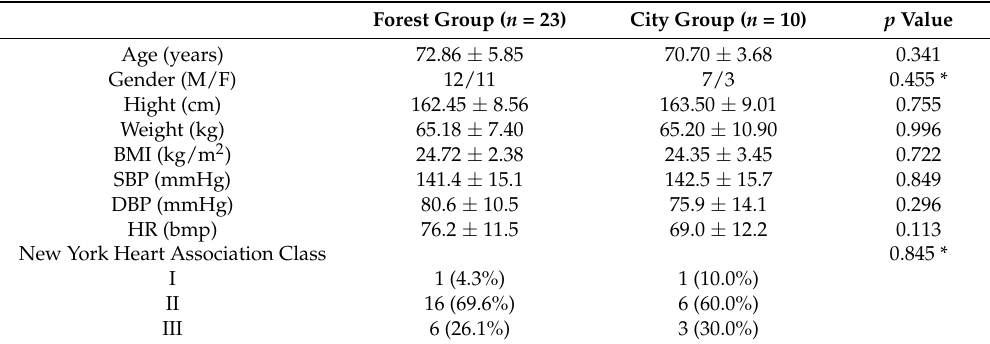
Table 1. Clinical characteristics of the participants (mean ± SD or number